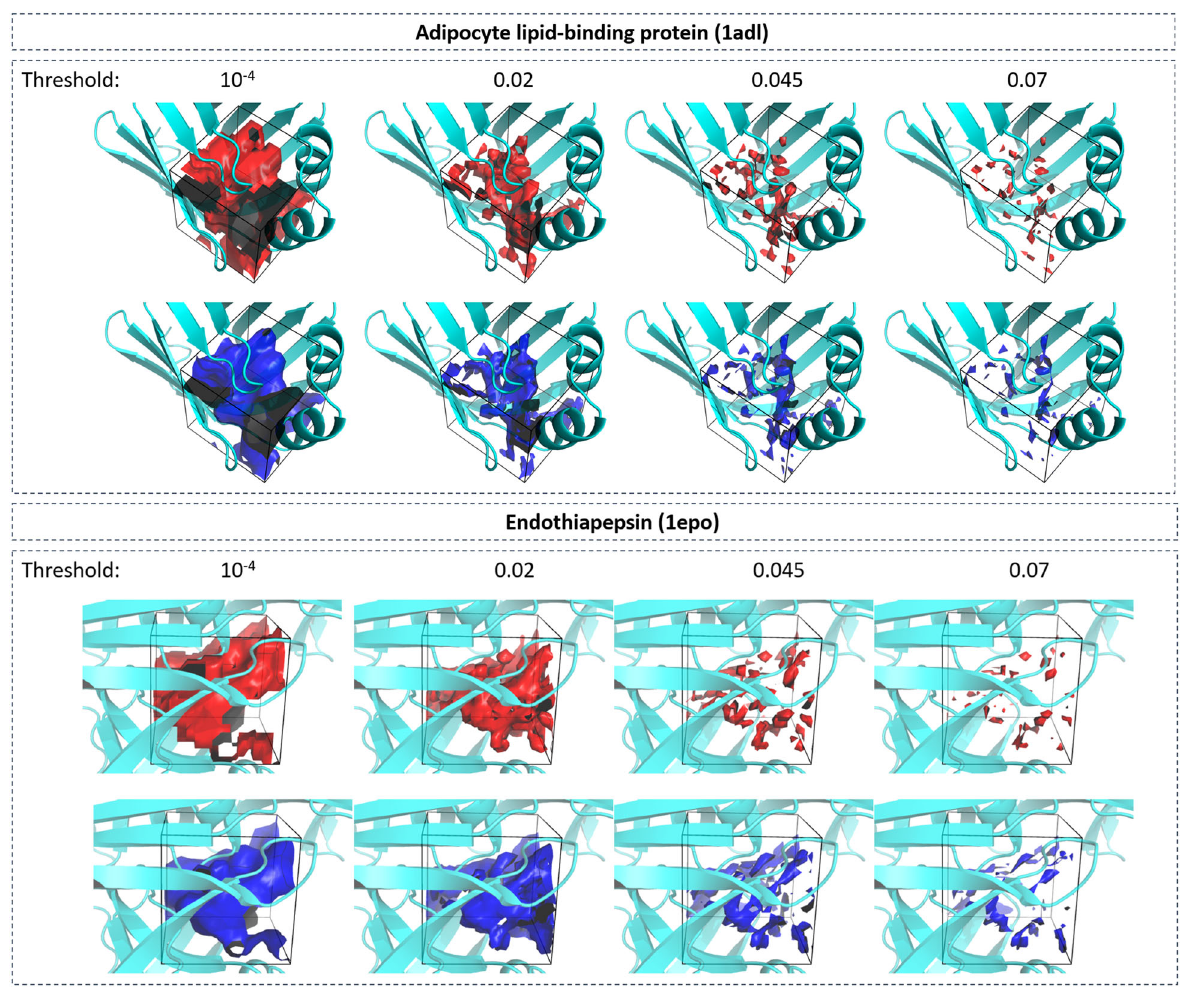
Fig. 8 Accuracy of regression model. Visual comparison between group truth (red) and neural-network predicted (blue) water occupancy for adipocyte lipid-binding protein (PDB-code: 1adl) and endothiapepsin (1epo). Predictions were performed using regression neural network. Isosurfaces at four different occupancy values (10 − 4 , 0.02, 0.045, and 0.07) are shown.